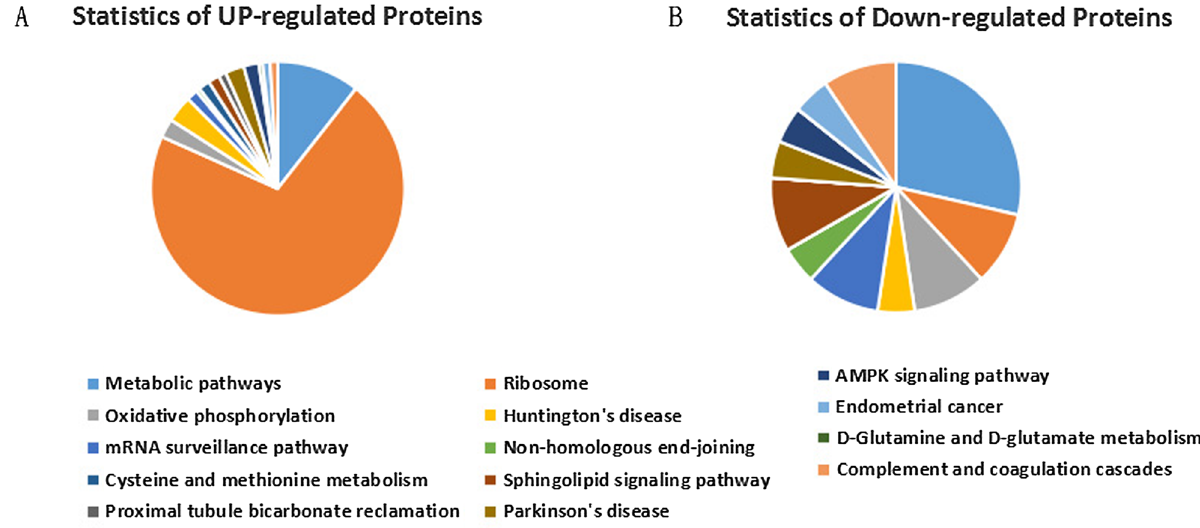
Figure 4. KEGG pathways classi fi cation of up- and down- regulated proteins in BHK cells infected with Eimeria tenella , including up-regulated proteins and down-regulated proteins.